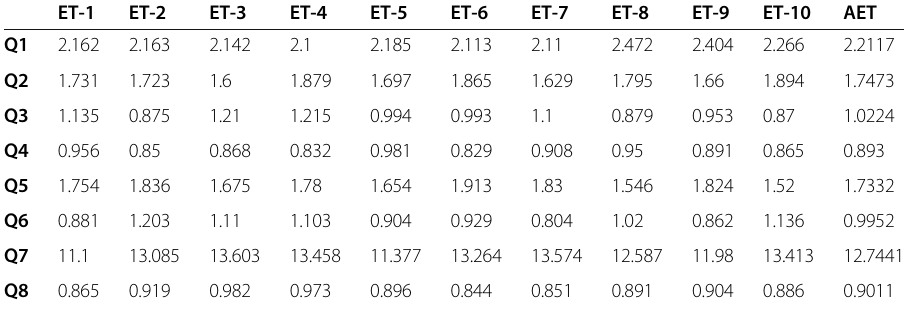
Table 8 Query execution time for Amazon RDS with Colorado State data for HC-1